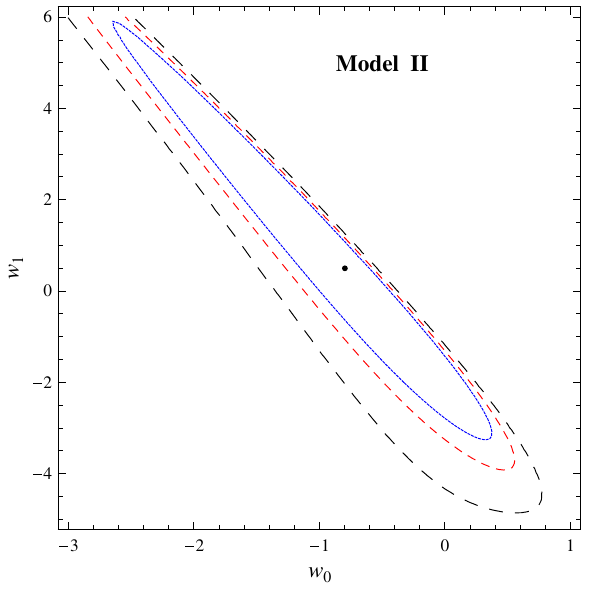
Fig. 9 Variations of w 0 and w 1 in the joint analysis (SNIa+BAO+CMB+Hubble) for the CPL parameterization (Model II). We plot the graphs for different confidence levels 66% (solid, blue), 90% (dashed, red) and 99% (dashed, black) contours for ( w 0 , w 1 ) by fixing the other parameters β = − 0 . 5 , D = 5 ,w m = − 0 . 3 ,ω =